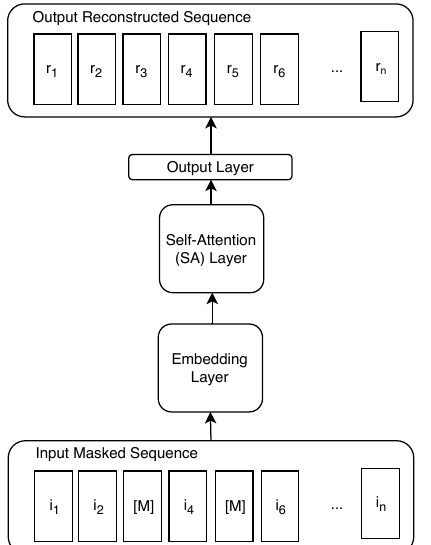
Figure 1. Proposed self-attention-based autoencoder (SABA)